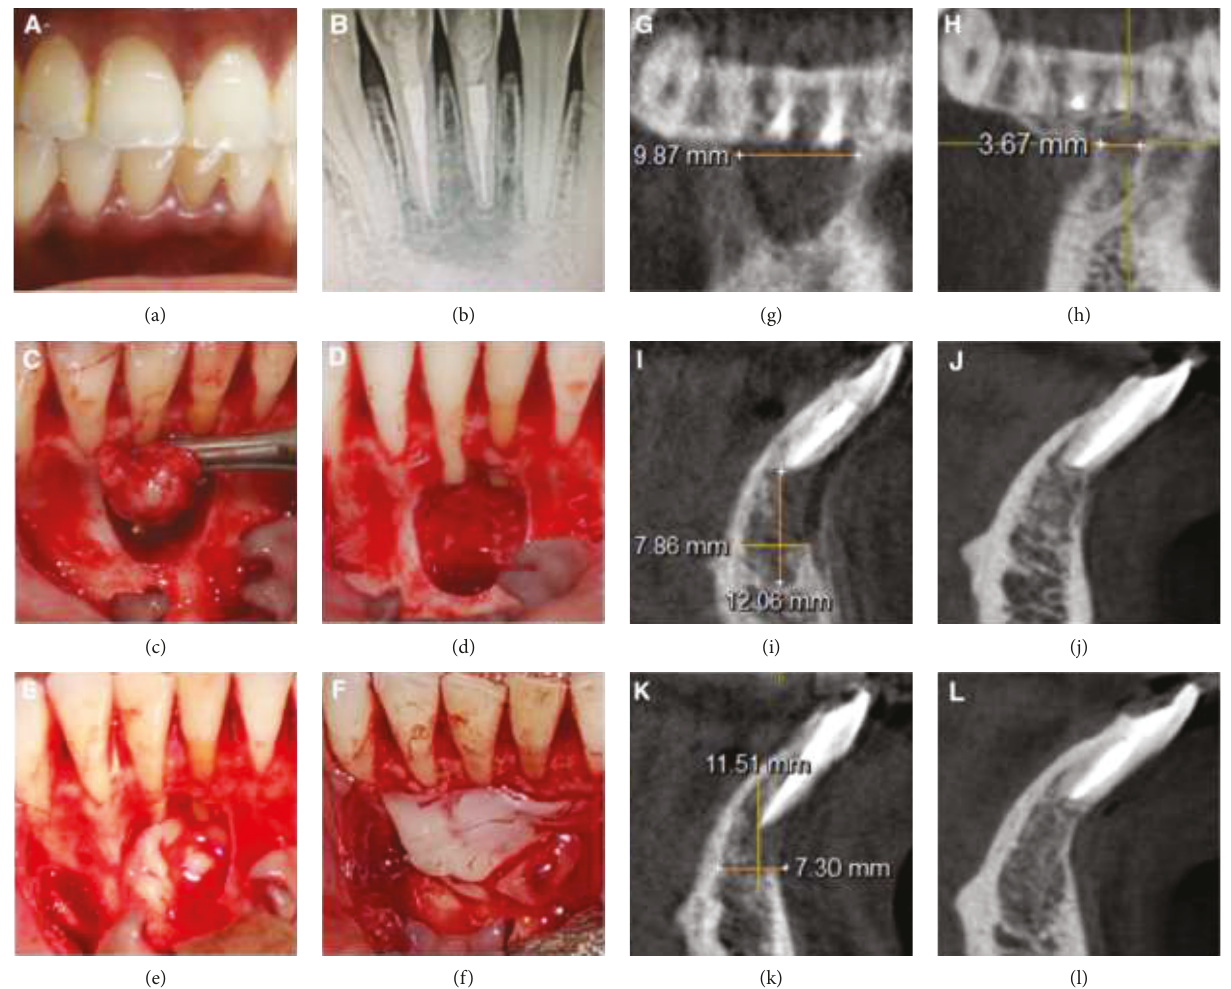
Figure 2: Preoperative clinical and surgical procedure and radiographic images: IOPA and CBCT images (Case Report 2). (a) Pre-op clinical photograph shows discoloured 31. (b) Preoperative IOPA showing the periapical lesion involving the apices of 11 and 12 and extending to the mesial margin of 13. (c) Complete curettage of the lesion. (d) Apicectomy done and MTA retrograde fi lling given in 31 and 41. (e) CGF fi brin-rich block placed in the bony defect. (f) CGF membrane placed before suturing of the fl ap. (g) Pre-op CBCT image showing the lesion measurement in the coronal slice. (h) Post-op CBCT image showing the lesion measurement in coronal slice. (i) Pre-op CBCT image showing the lesion measurement in sagittal slice corresponding to 41. (j) Post-op CBCT image showing the lesion measurement in sagittal slice corresponding to 41. (k) Pre-op CBCT image showing the lesion measurement in sagittal slice corresponding to 31. (l) Post-op CBCT image showing the lesion measurement in sagittal slice corresponding to